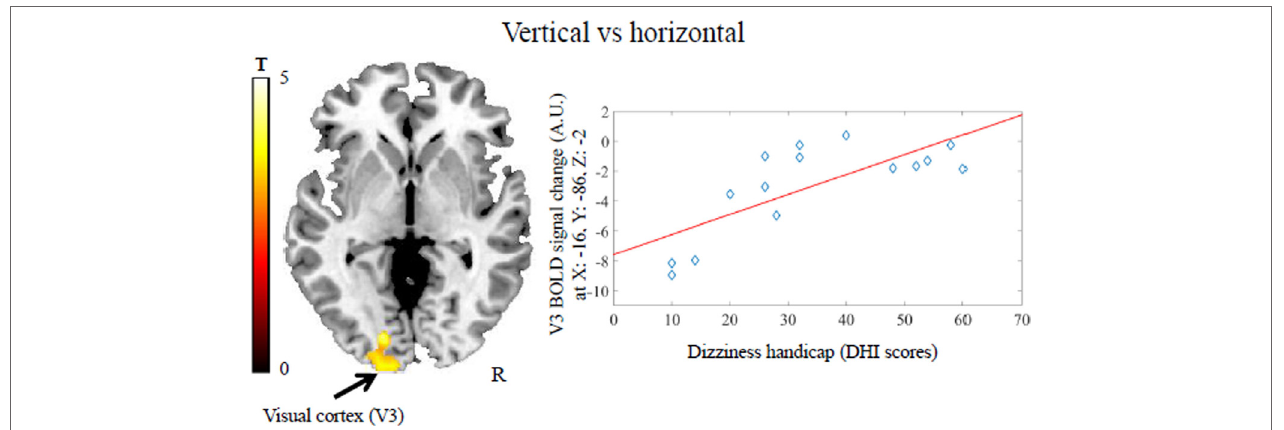
FigUre 3 | Positive association between dizziness handicap [i.e., scores on the Dizziness Handicap Inventory (DHI)] and visual cortex activity (V3) in patients with persistent postural-perceptual dizziness for the contrast vertical vs horizontal motion. This result survived a cluster-wise corrected threshold of p < 0.05 after Monte Carlo simulations within the brain mask including the regions of interest. The coordinates ( x , y , z ) are in the Montreal Neurological Institute space. Each dot represents individual mean BOLD responses within the displayed cluster; red line represents the regression line. The color bar represents t -statistics. BOLD, blood oxygenation level-dependent signal; A.U., arbitrary unit; R, right hemisphere.